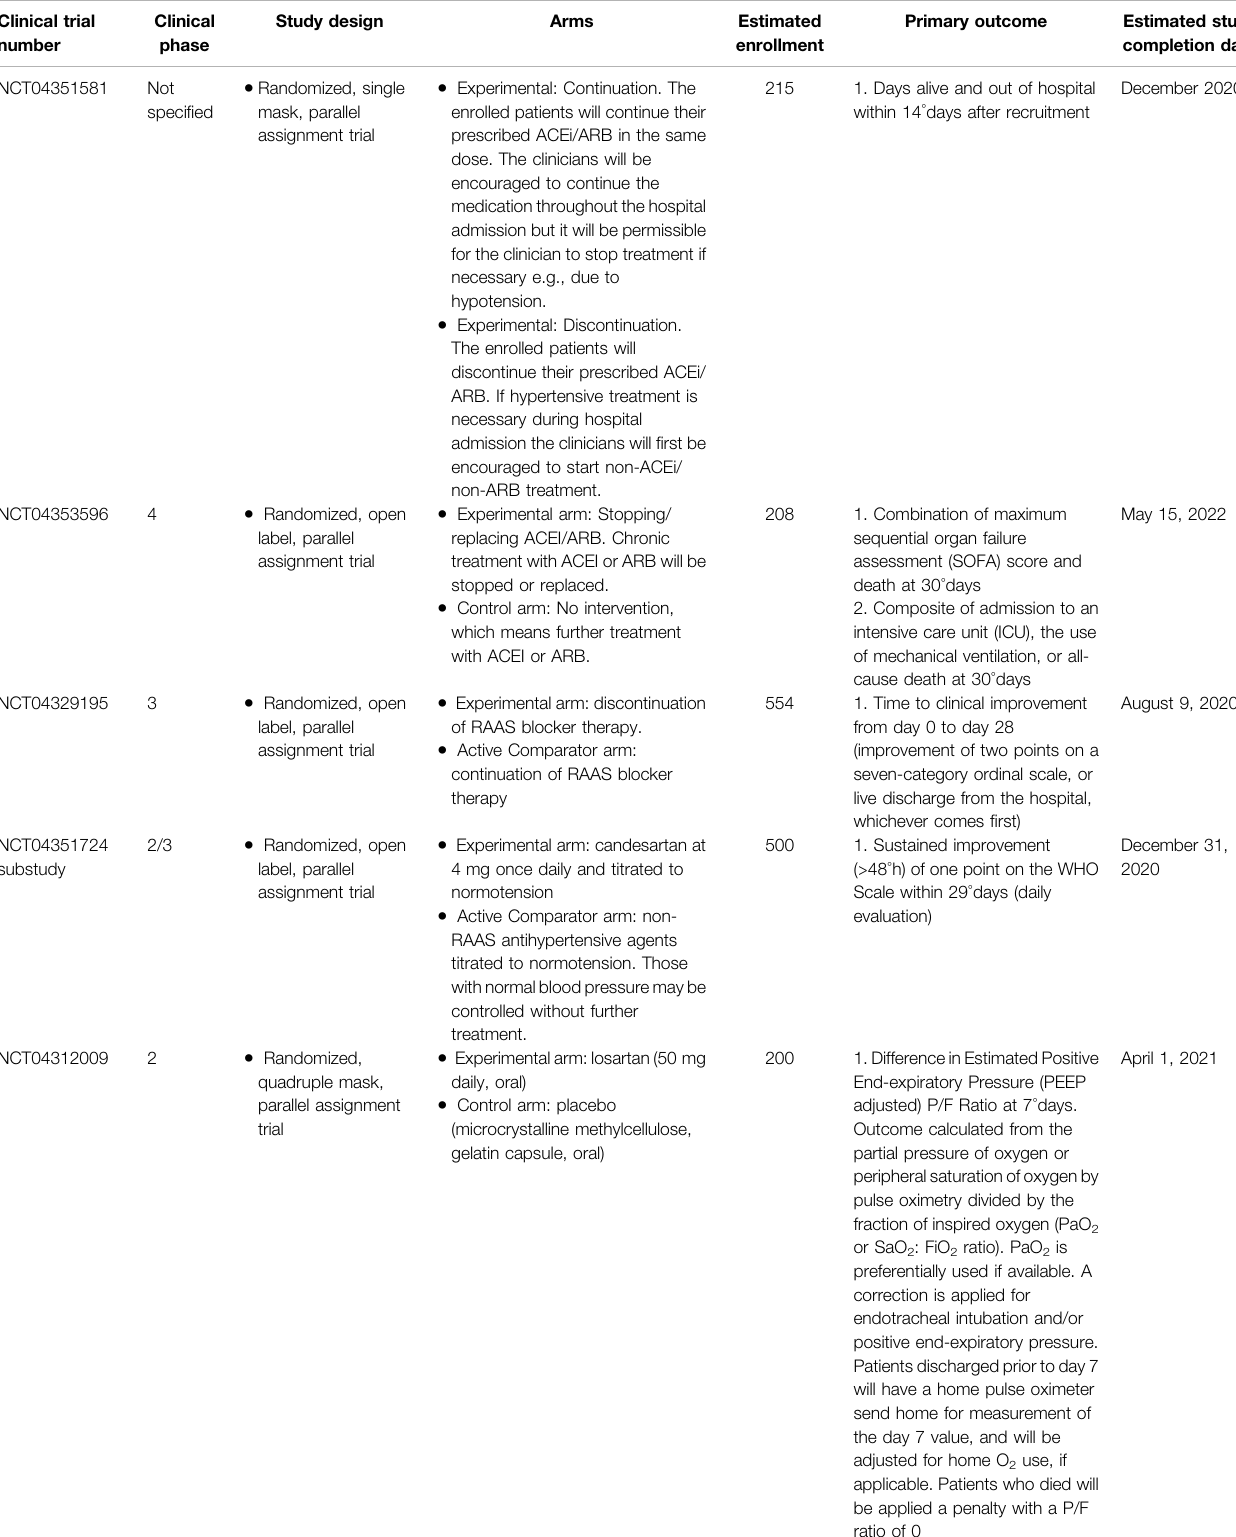
TABLE 1 | Characteristics of ongoing clinical trials on the continuation or suspension of RAAS blockers in patients with COVID-19, and on the ef fi cacy of ACE inhibitors, ARBs, angiotensin 1-7, and ACE2 for COVID-19. Clinical trial